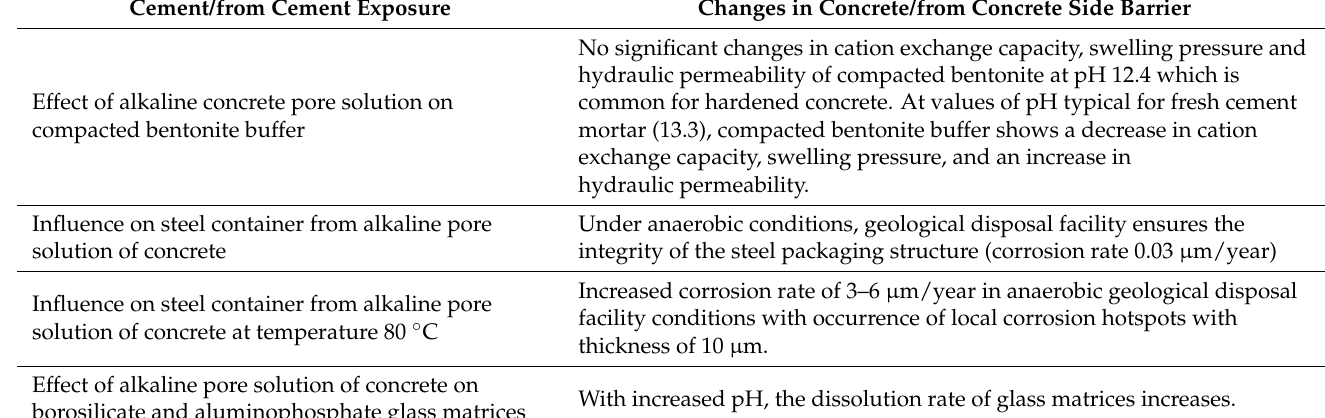
Table 8. Transformation of engineered barrier system components under alkaline concrete pore solution